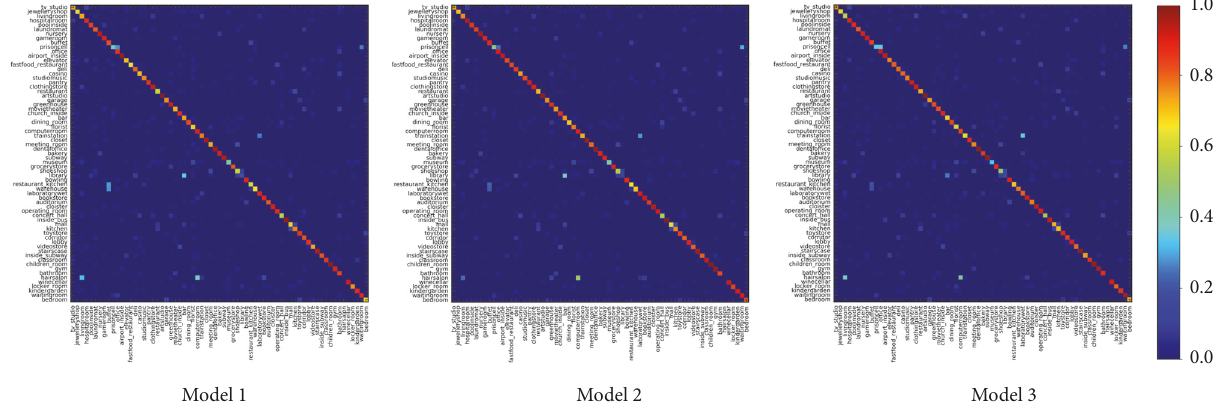
Figure 10: Scene classification test confusion matrixes by the models trained on MIT 67